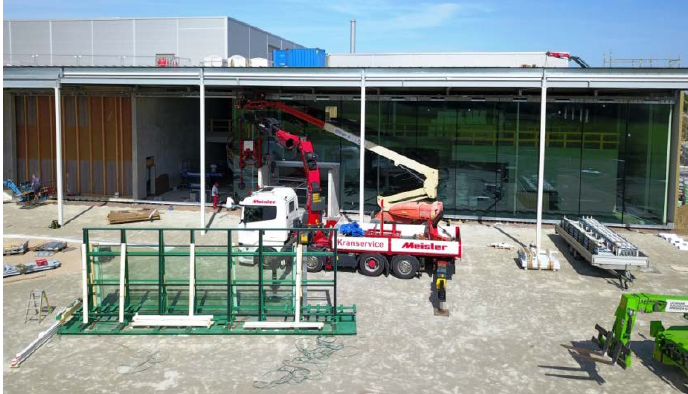
Fig. 6 View of the construction site of the filter factory Wilsdruff during the glazing process.